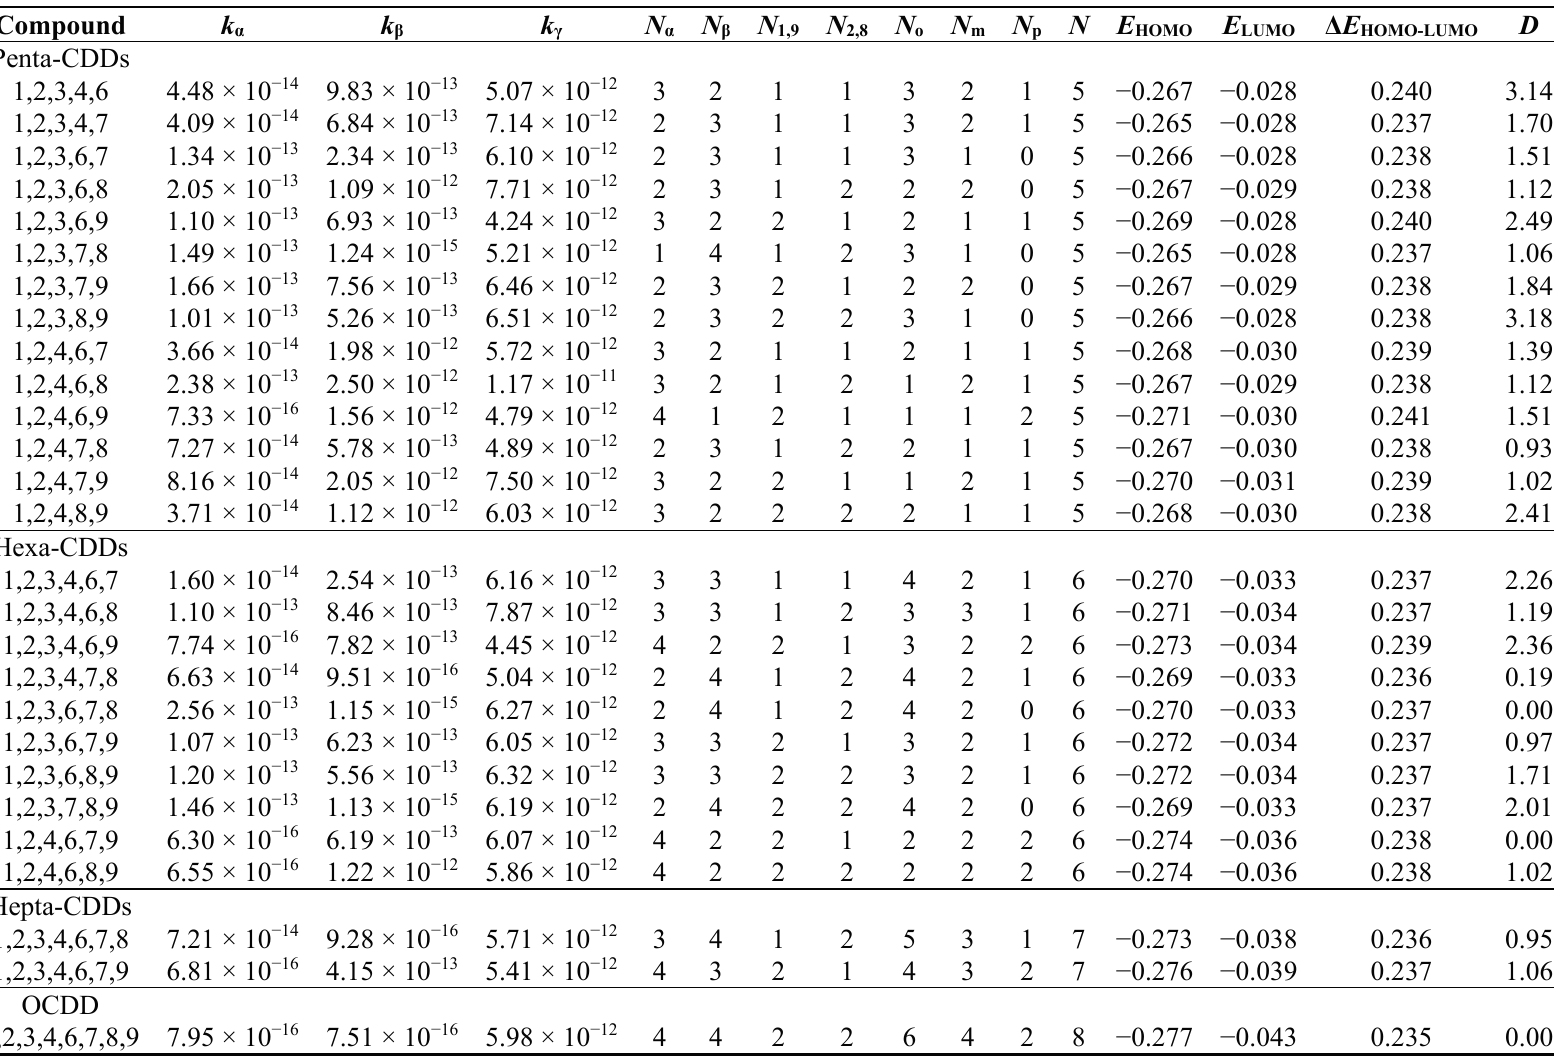
Table 3. The rate constants ( k α , k β , k γ ) of Penta-CDDs, Hexa-CDDs, Hepta-CDDs and OCDD with